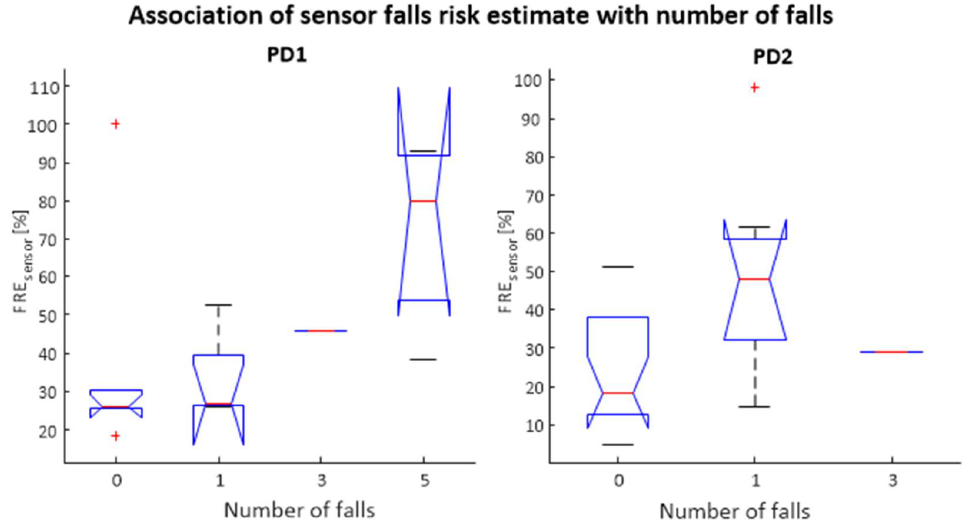
Figure 3. Association between FRE sensor and falls counts for two statistically independent datasets (PD1 (left) and PD2 (right)). The PD1 dataset took falls counts at 24 weeks post baseline assessment.